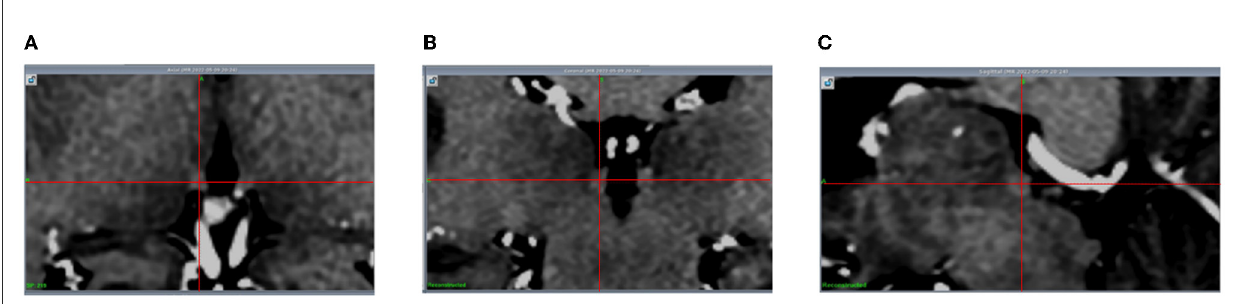
FIGURE1 The Hb is visible (with the intersection of the red lines indicating the center of the left Hb) in 3D T1-weighted MR images. (A) Axial; (B) Coronal; (C) Sagittal.